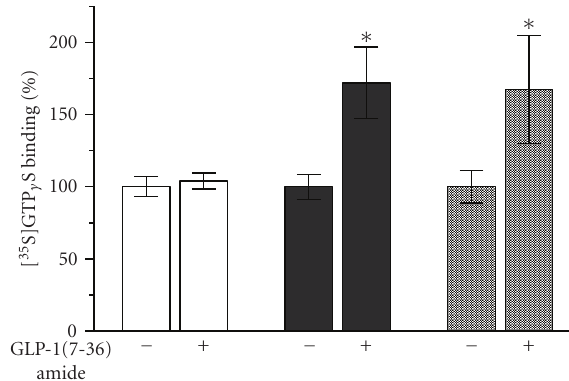
Figure 5: E ff ect of GLP-1(7-36)amide on the initial rate of [ 35 S]GTP γ S binding to the plasma membranes from CHO cells transiently expressing GLP-1 receptor and GFP-GLP-1 receptor. Mock (empty bar); GFP-GLP-1 receptor (filled bar); GLP-1 receptor (patterned bar). 100% = 11 . 1 fmol/mg/min for CHO, 13.4 fmol/mg/min for GFP-GLP-1 receptor, and 9.8 fmol/mg/min for GLP-1 receptor (basal values, no GLP-1(7-36)amide added). Each bar with the indicated standard deviation represents the mean value of three independent experiments done in duplicate. ANOVA: F(5, 12) = 9.95; P < .001. Tukey-Kramer multiple comparison test was used to reveal significant di ff erences between groups of interest. See Results for the details.